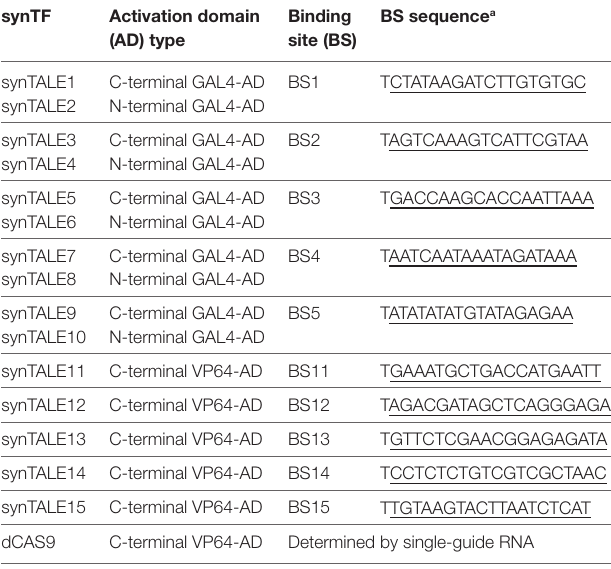
Table 1 | Synthetic transcription factors (synTFs) and target sites used in this